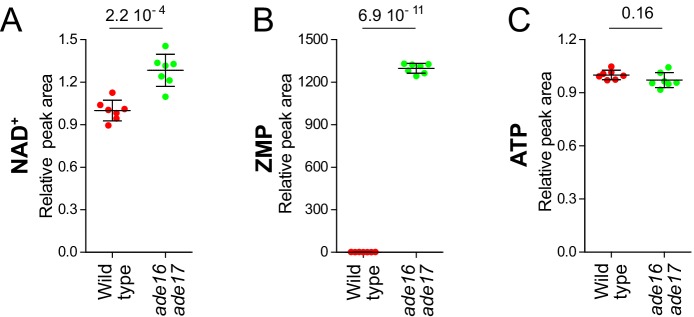
NAD+ level is significantly increased in the ade16 ade17 (S)ZMP accumulating mutant in the absence of external nicotinic acid.Wild-type (BY4742, red dots) and ade16 ade17 (Y1162, green dots) were exponentially grown for 24 hr in SDcasaWAU medium lacking nicotinic acid. Metabolite extraction, separation and quantification were done as in Figure 2. Quantifications were determined from independent metabolite extractions (N ≥ 7) and standard deviation is presented. Values measured in wild-type cells (red dots) were set at 1. Indicated p-values were calculated using a Welch’s t-test.10.7554/eLife.43808.035Figure 5—figure supplement 1—source data 1.Metabolic analyses for wild-type and ade16 ade17 mutant strains grown in NA-free medium.